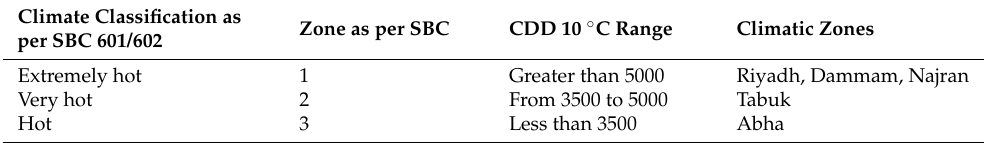
Table 4. Climatic classification under Saudi Building Code (SBC)